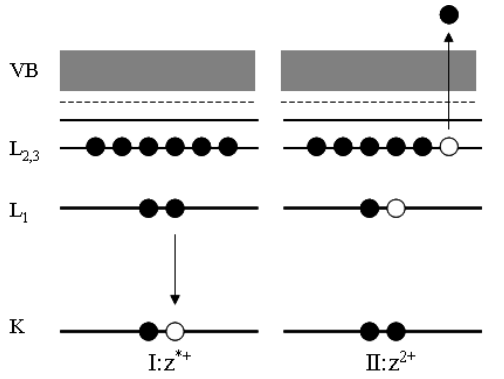
Figure 2. Auger emission steps. I: after core electron emission, the core hole left by photoelectron ( ο ) is filled by an outer electron. II: the energy available from the filling of the initial core hole is used for emitting a second electron, the Auger electron. In this case the Auger electron is named KL 1 L 2,3 , or simply KLL. The result is a doubly ionized atom. VB: Valence